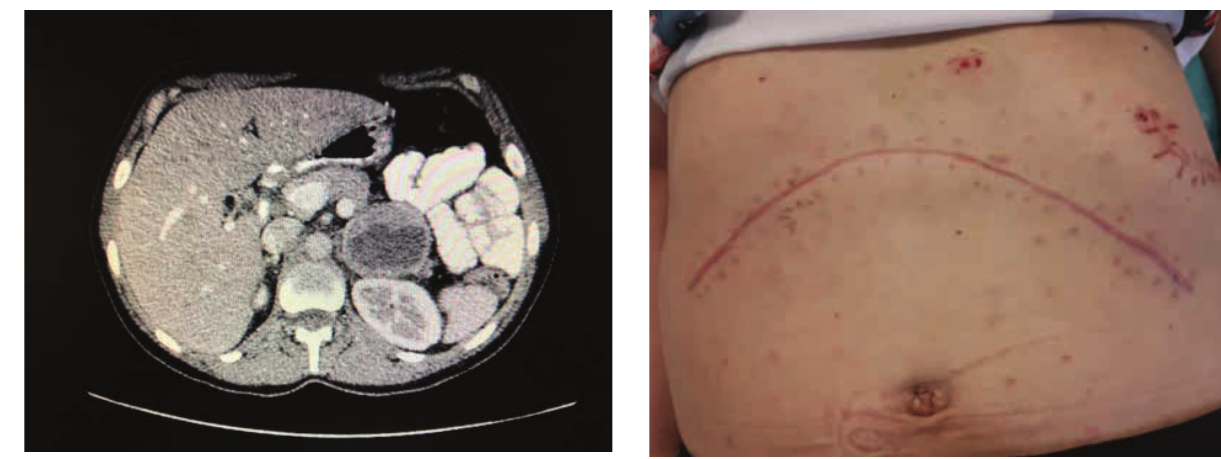
Figure 2: CT scan with tumor resembled pheo of left adrenal gland Figure 4: Incisions after 1st and 2nd